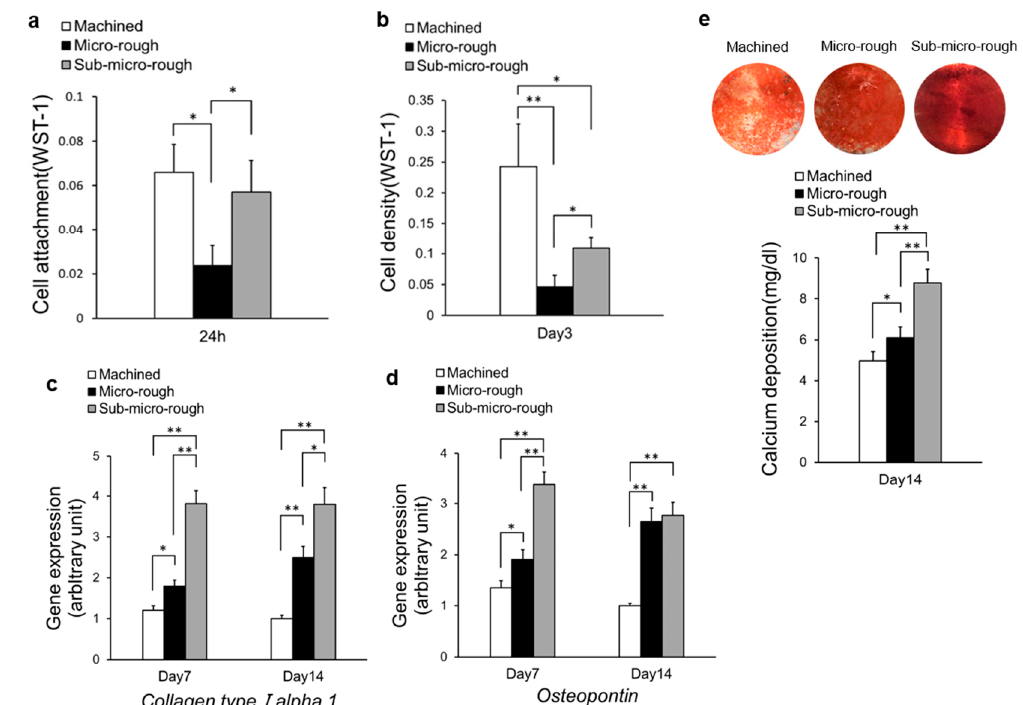
Figure 3. Biological characteristics of osteoblasts on three di ff erent titanium surfaces. ( a ) Number of cells attached to each titanium surface during a 24 h incubation, evaluated by a WST-1 assay. ( b ) Cell density evaluated at culture day 3 using a WST-1 assay. ( c , d ) Real-time qPCR analysis of mRNA expression of bone-related genes collagen type I alpha 1 and osteopontin on titanium surfaces at day 7 and day 14 using osteoblastic cell cultures. Relative expression levels (2 – ∆∆ Ct values) of the genes of interest were normalized to that of the housekeeping gene Gapdh . ( e ) Representative images of mineral deposition evaluated by Alizarin red staining at culture day 14 (top). Colorimetric detection of total calcium deposition measured on the same day (bottom). Each value represents the mean ± standard deviation of triplicate experiments ( n = 3). * p < 0.05, ** p < 0.01, one-way ANOVA followed by Tukey’s test.